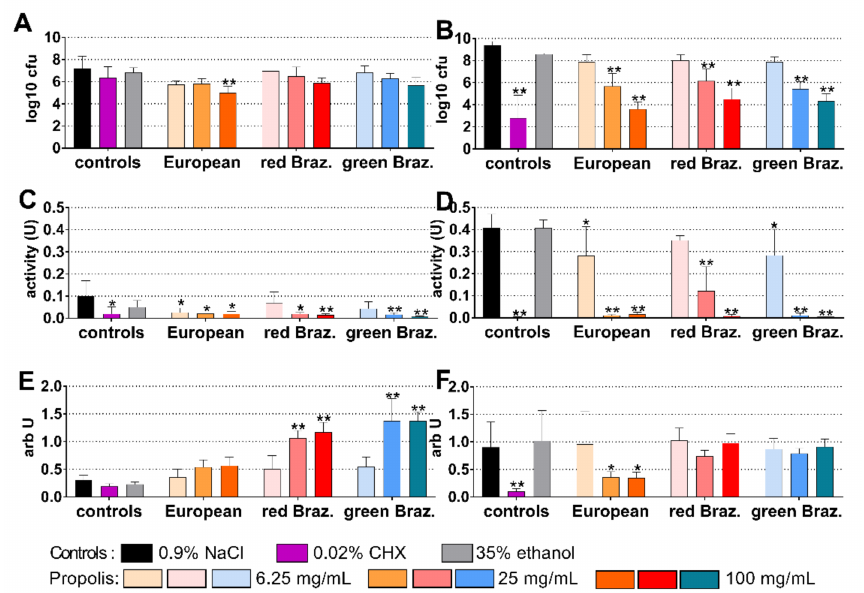
Figure 3. Activity of the different ethanolic extracts of propolis (European and red and green Brazilian (Braz.)) on colony forming units (cfu; ( A , B )), metabolic activity ( C , D ) and quantity ( E , F ) in a formed